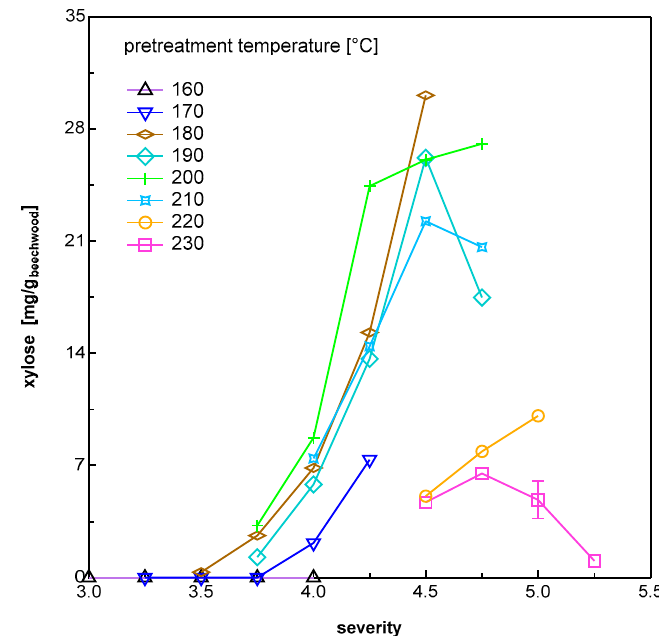
Figure 1. Release of soluble xylooligomers during steam explosion pretreatment. Shown are the amounts of soluble xylooligomers that are released into the prehydrolyzate during steam explosion pretreatment as function of the pretreatment severity and temperature.